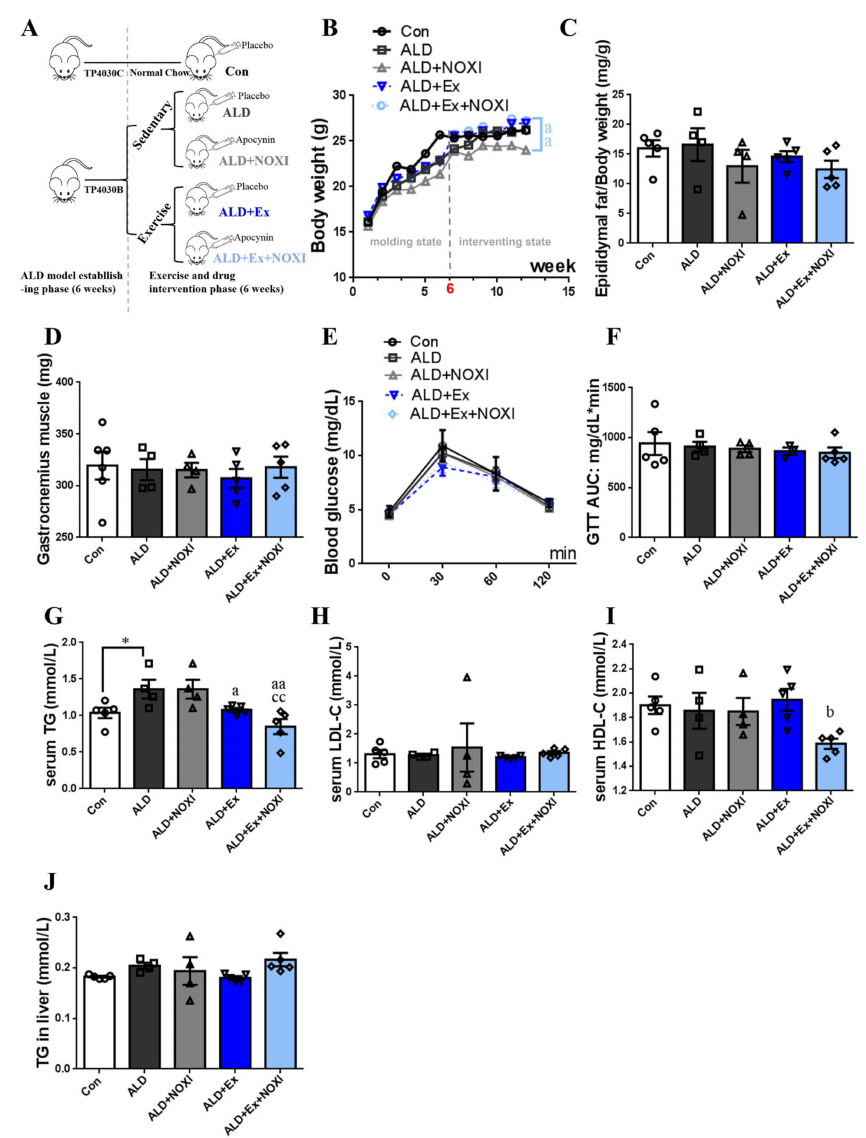
Figure 1. Inhibition of NOX affects the normal weight gain of mice, and exercise training amelio- rates dyslipidemia and hepatocyte inflammatory damage. ( A ) Grouping of experimental animals. ( B ) Changes in body weight over 12 weeks. ( C ) Ratio of epididymal fat to body weight. ( D ) Gastroc- nemius muscle weight. ( E , F ) Glucose change and area-under-the-curve in glucose tolerance test. ( G , J ) TG content in serum and liver tissue. ( H ) LDL-C in serum. ( I ) HDL-C in serum. ( A – J ) Con group, n = 5; ALD group, n = 4; ALD + NOXI group, n = 4; ALD + Ex group, n = 5; ALD + Ex + NOXI group, n = 5. The molding effect is represented by *, * p < 0.05. The exercise effect is denoted by a, a p < 0.05 and aa p < 0.01. The drug effect is denoted by b, b p < 0.05. The effect of combined exercise and drug intervention is indicated by c, cc p <